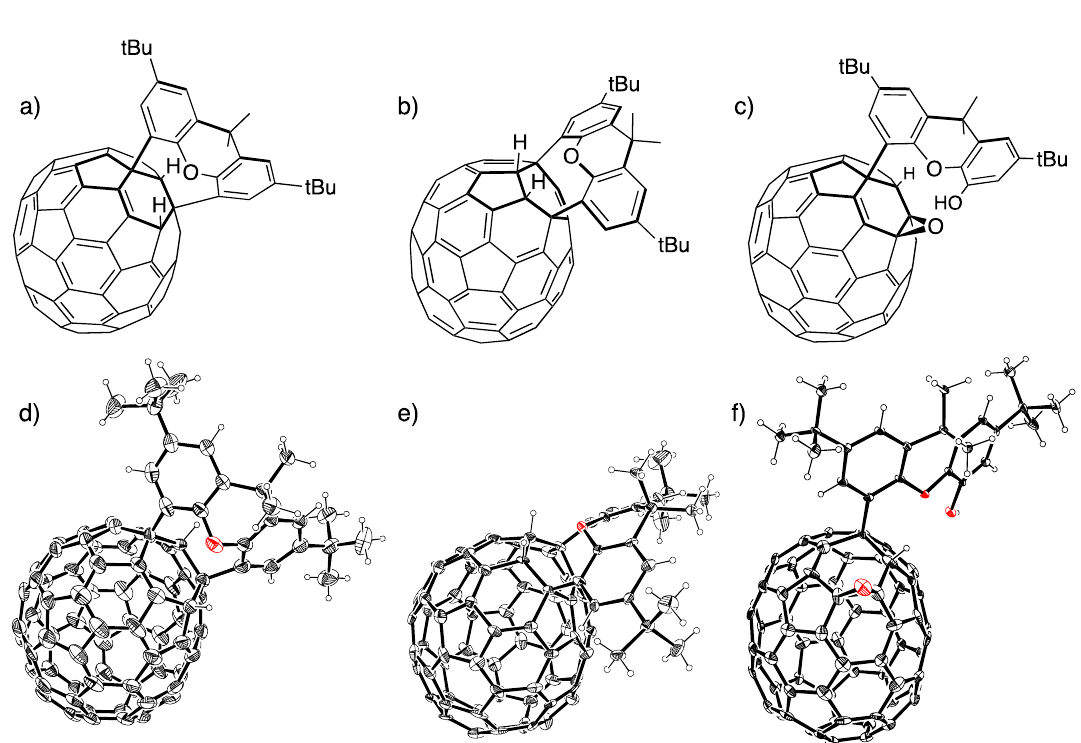
Figure 3. Structures of X70A , X70B , and X70F . Molecular structures of ( a ) X70A , ( b ) X70B , and ( c ) X70F and their ORTEP diagrams for single-crystal X-ray structures of ( d ) X70A , ( e ) X70B , and ( f ) X70F with 25% thermal ellipsoids. Solvent molecules and disordered parts are omitted for